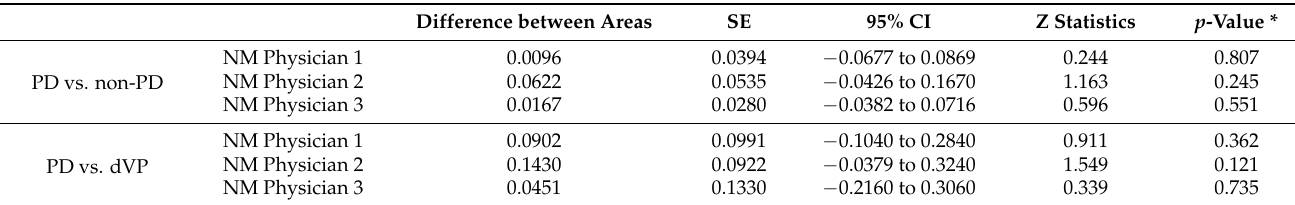
* Comparison with the faster region-based convolutional neural network; ROC, receiver operating characteristic; PD, idiopathic Parkinson’s